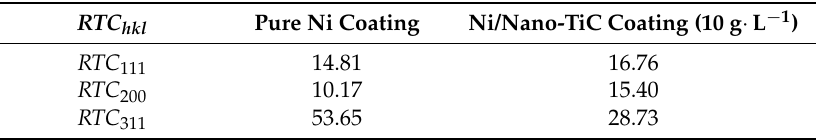
Table 2. Relative texture coefficient RTC hkl of the pure nickel and Ni/nano-TiC functional composite